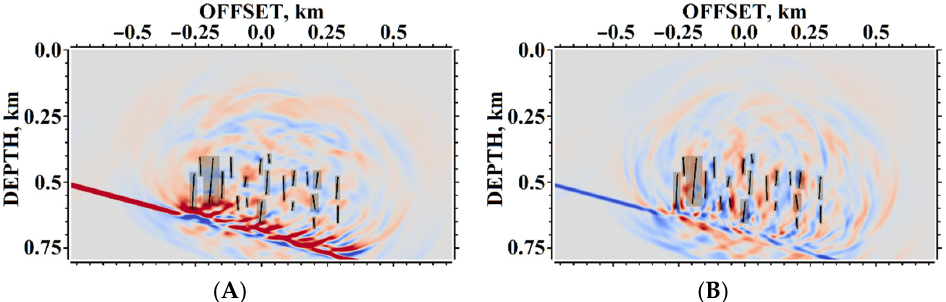
Figure 24. Example #1, incident S-wave, snapshots at the time moment 0.38 s: ( A ) horizontal component of velocity; ( B ) vertical component of velocity.